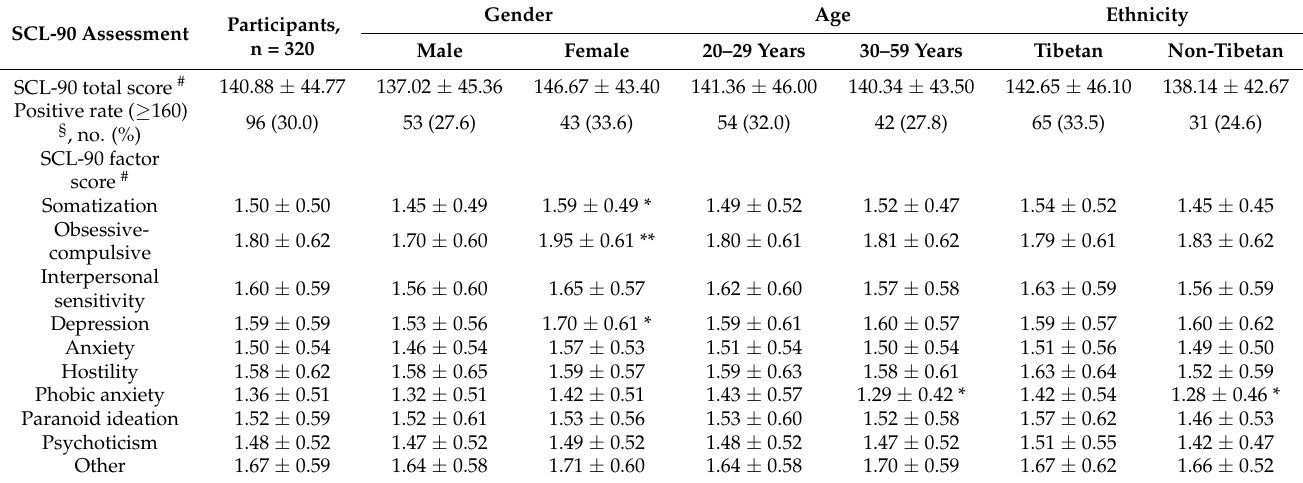
Table 3. Psychological fitness: results of the SCL-90